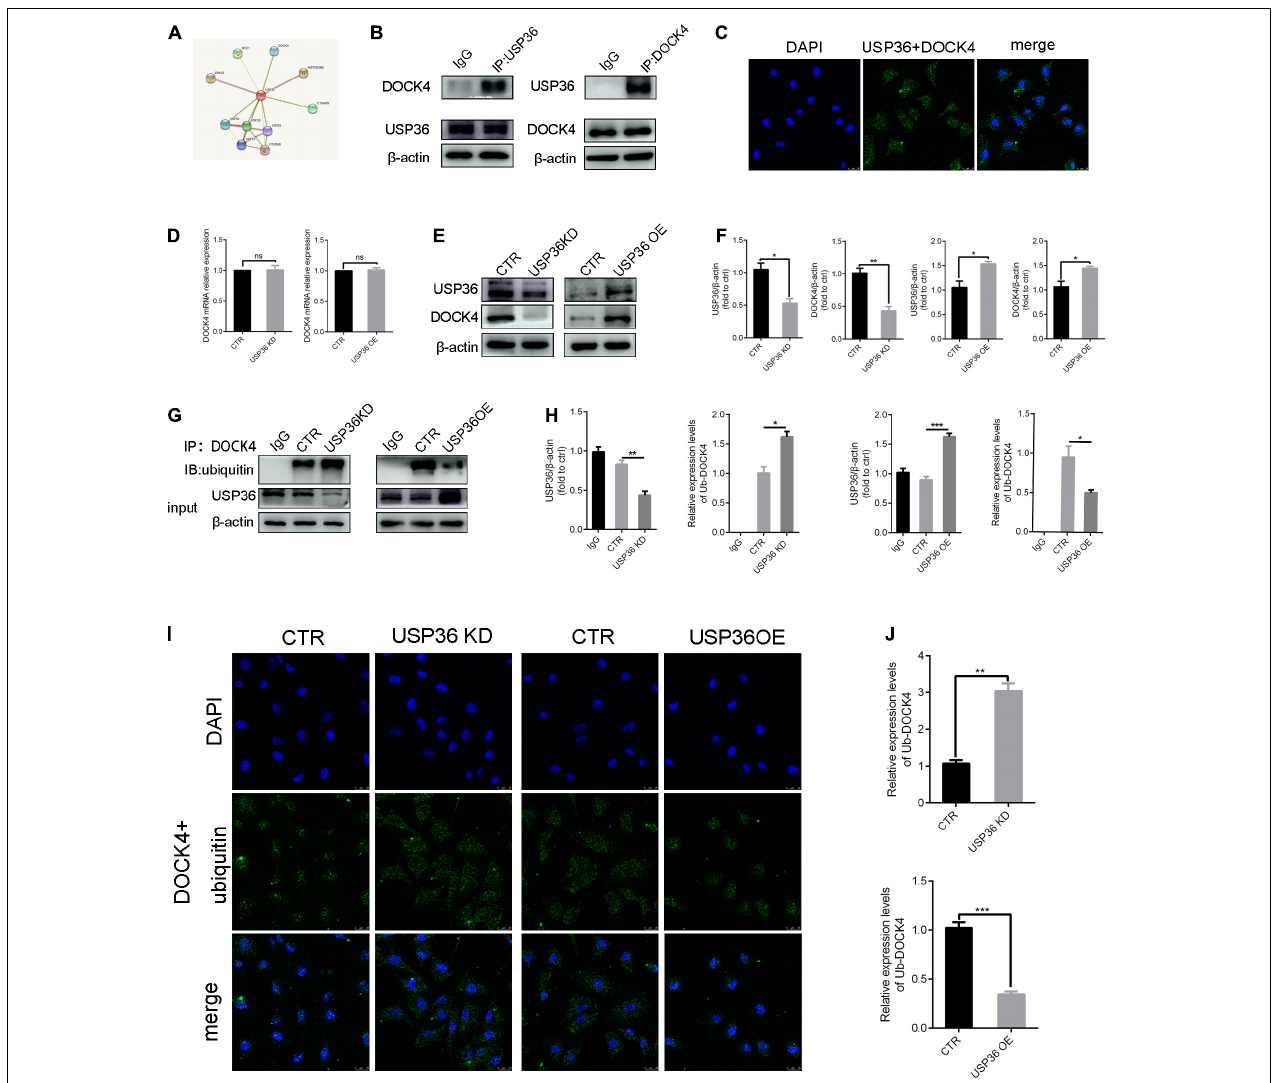
FIGURE 4 | USP36 regulates the ubiquitination level of DOCK4. (A) String website was performed to predict that USP36 can bind to DOCK4. (B) Immunoprecipitation analysis was performed with cell lysates of TECs with anti-USP36 or anti-DOCK4 antibodies, n = 3. (C) Interaction of USP36 and DOCK4 in TECs visualized by Duolink proximity ligation assay, n = 3. (D) RT-qPCR analysis of the mRNA level of DOCK4 after knockdown or overexpression of USP36. Unpaired, two-tailed t tests were used to compare groups, n = 3, ns, p > 0.05. (E,F) WB analysis of the protein levels of USP36 and DOCK4 in TECs after knockdown or overexpression of USP36. Data are presented as the mean ± S.D, n = 3, * p < 0.05, ** p < 0.01. (G,H) WB analysis of the protein levels of USP36 and the ub-DOCK4 in TECs after knockdown or overexpression of USP36. Data are presented as the mean ± S.D, n = 3, * p < 0.05, ** p < 0.01, *** p < 0.001. (I) Ub-DOCK4 was detected by Duolink proximity ligation assay after knockdown or overexpression of USP36. Scale bars = 25 µ m, n = 3. (J) Duolink proximity ligation assay analysis of ub-DOCK4 expression after knockdown or overexpression of USP36. Data are presented as the mean ± S.D, n = 3, ** p < 0.01, *** p <